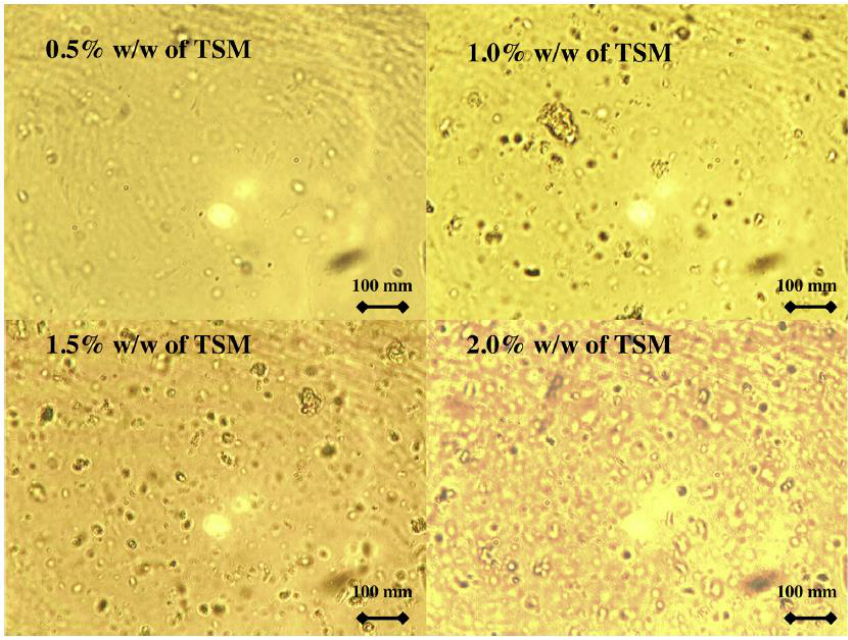
Figure 17. Optical microscopy images for 0.5%, 1.0%, 1.5%, and 2.0% ( w / w ) tamarind seed mucilage dispersions. Reproduced with permission from [104]. (Copyright 2018 Elsevier).